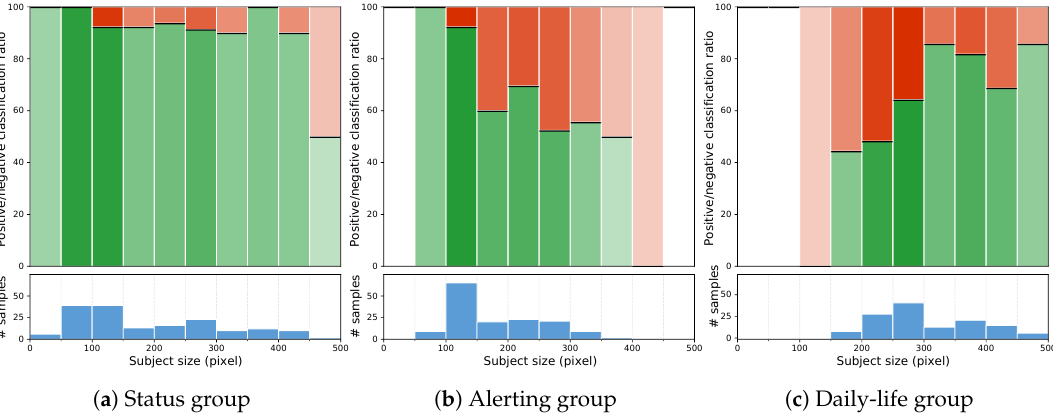
Figure 7. Dependence of classification accuracy on the apparent size of the subject in the image